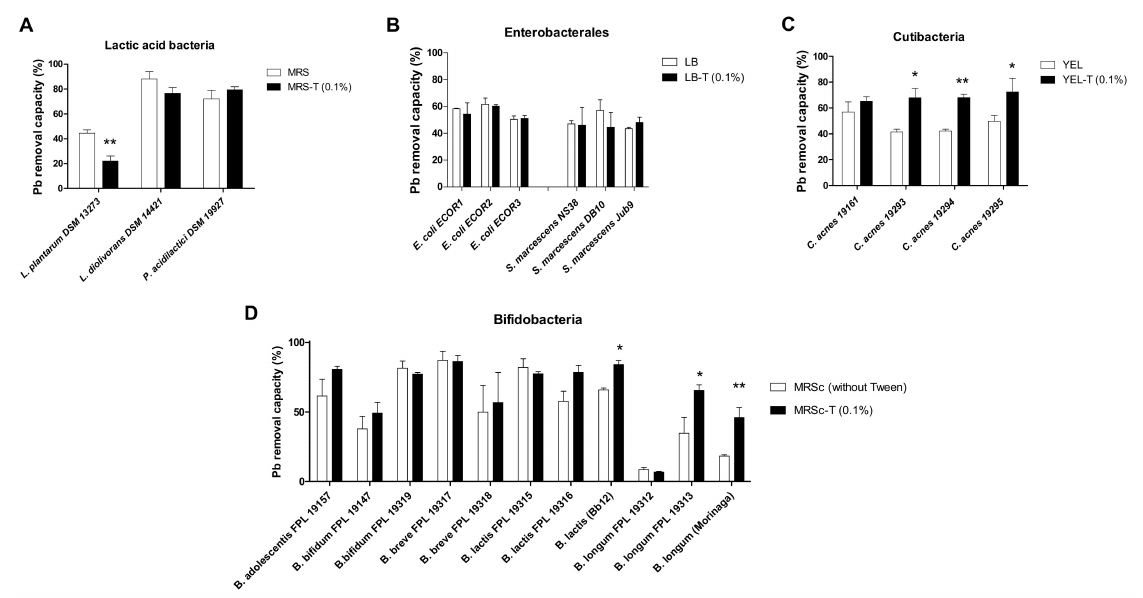
Figure 5. The Pb(II) removal ability of various bacterial strains grown with Tween ® 80. ( A ) lactic acid bacteria were grown in MRS medium (white bars) or in MRS medium containing 0.1% Tween ® 80 (MRS-T 0.1%, black bars). ( B ) Enterobacterales (i.e., E. coli and S. marcescens strains) were grown in LB medium (white bars) or in LB containing 0.1% Tween ® 80 (LB-T 0.1%, black bars). ( C ) Cutibacterium acnes strains were grown in YEL medium (white bars) or in YEL containing 0.1% Tween ® 80 (YEL-T 0.1%, black bars). ( D ) Eleven bifidobacteria strains from five species were grown in MRSc medium (white bars) or in MRS medium containing 0.1% Tween ® 80 (MRSc-T 0.1%, black bars). The data are expressed as the mean ± SD % of metal removed from the solution (starting concentration: 25 ppm) in triplicate experiments. * p < 0.05; ** p < 0.01 for Tween-free media vs. the same media with 0.1% Tween ® 80, in each